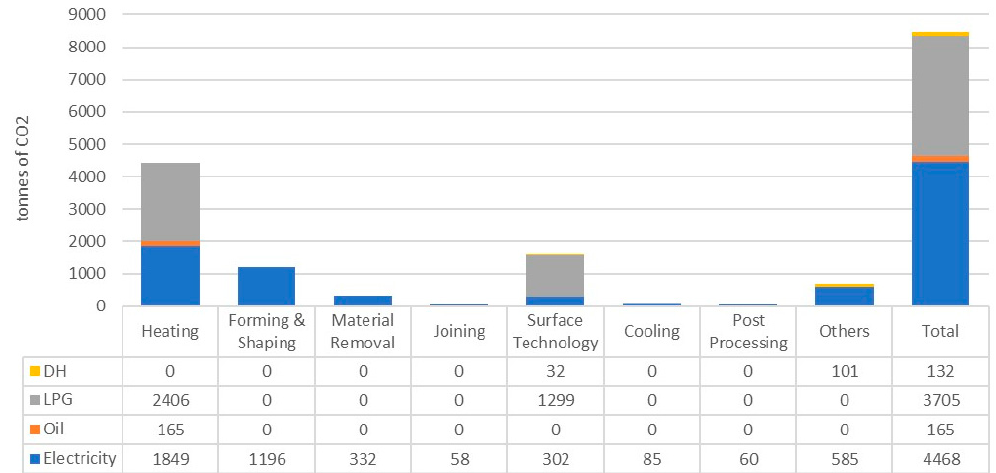
Figure A2. CO 2 emissions for the unit processes in the production category based on the case study of the Swedish engineering industry (Scenario